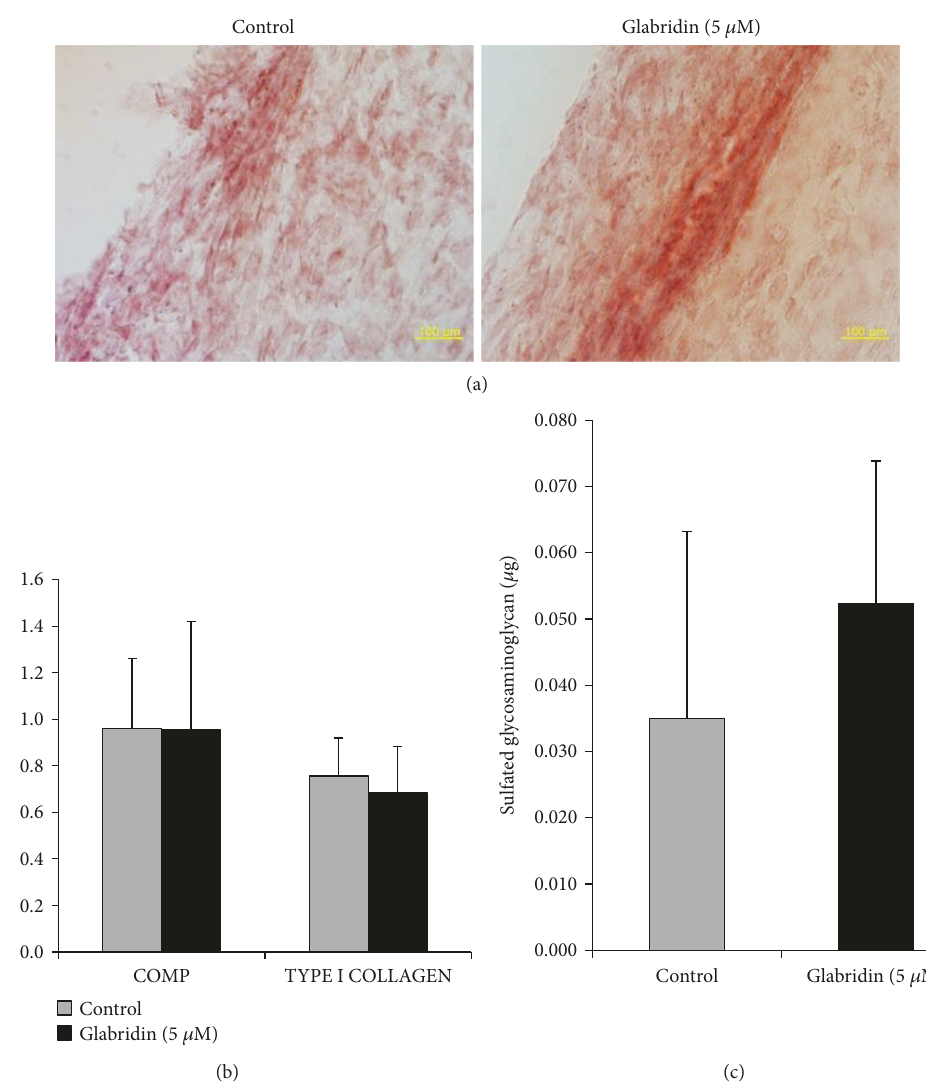
Figure 5: E ff ect of glabridin on chondrogenesis in MSCs. (a) Chondrogenic di ff erentiation was evaluated by safranin O staining (magni fi cation: 200x). (b) Chondrogenic potential was analyzed by levels of COMP and TYPE I COLLAGEN gene expression using RT-PCR. (c) Di ff erentiation of MSCs into chondrocytes was determined by glycosaminoglycan quanti fi cation. The data are expressed as the mean ± SD of three